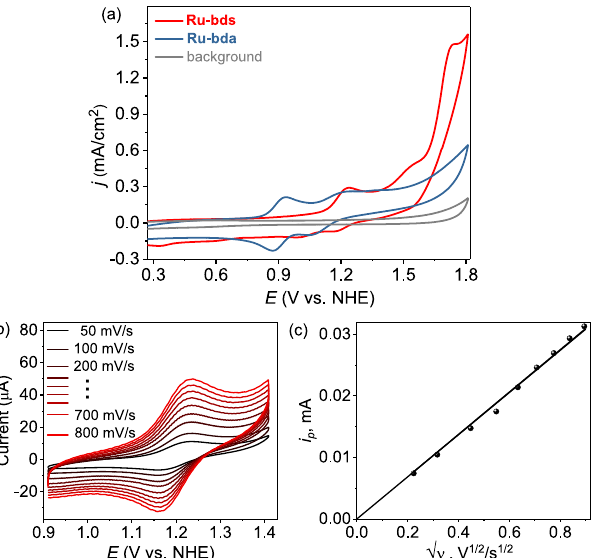
Fig. 2 X-ray crystal structure. The X-ray crystal structure of Ru-bds with thermal ellipsoids at 50% probability (hydrogen atoms are omitted for clarity).